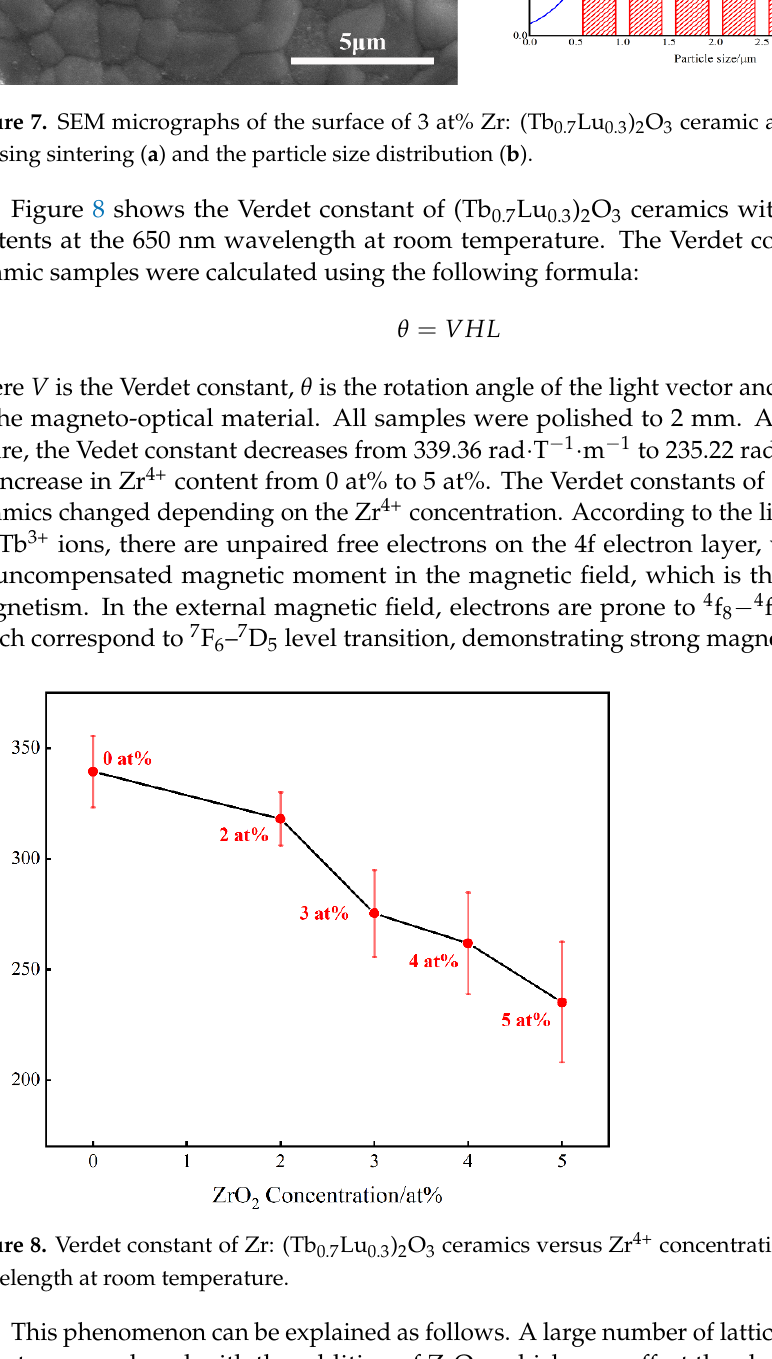
Figure 7. SEM micrographs of the surface of 3 at% Zr: (Tb 0.7 Lu 0.3 ) 2 O 3 ceramic after hot isostatic pressing sintering ( a ) and the particle size distribution ( b ).